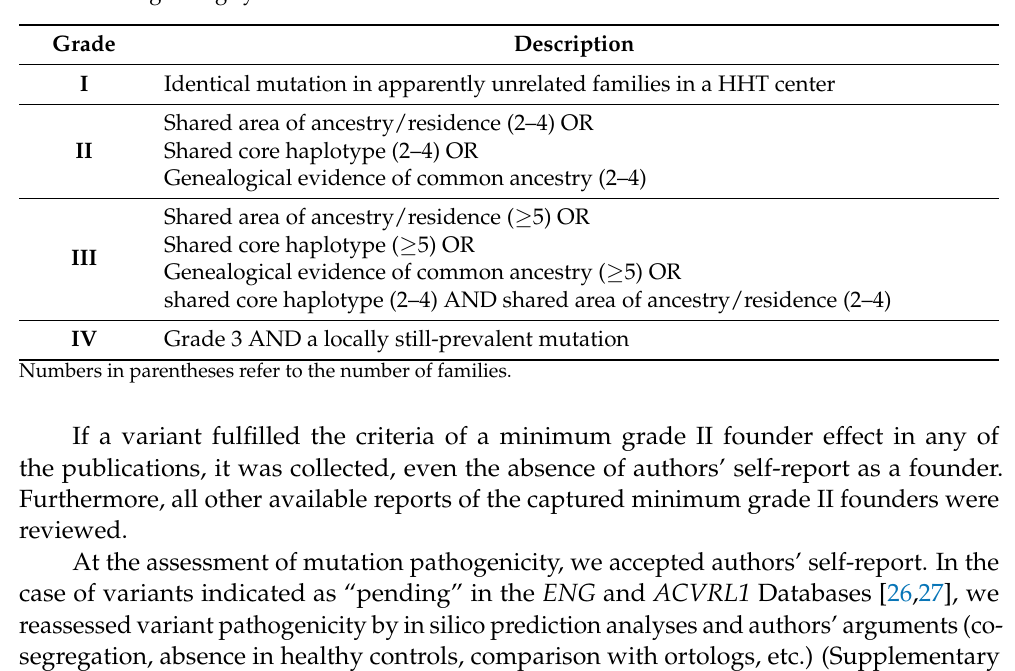
Table 1. Our grading system to assess evidences for founder effects in